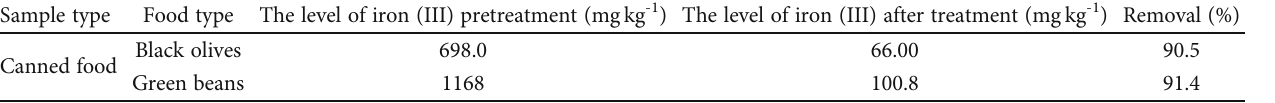
Table 1: Application studies on real canned food